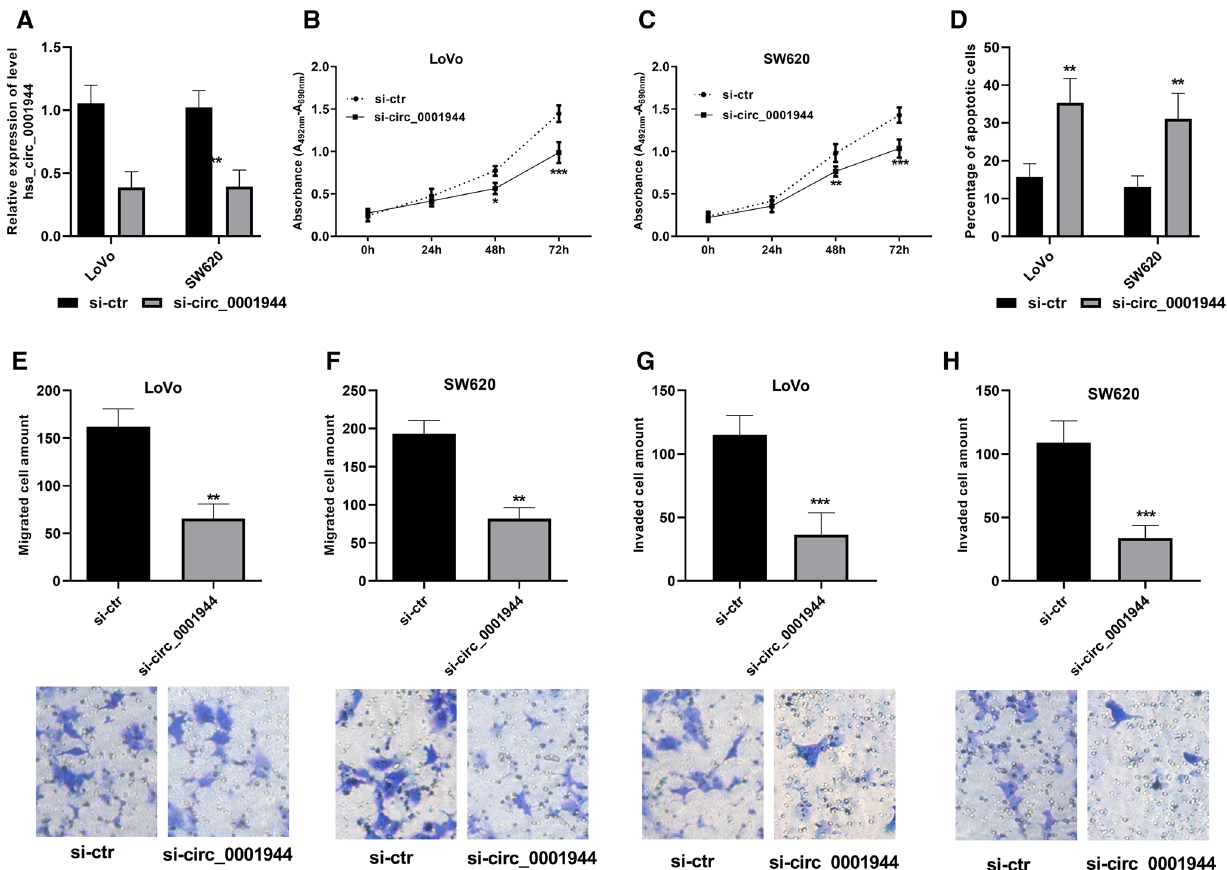
Fig. 2 Inhibition of hsa_circ_0001944 decreased cell proliferation, reduced the migrated and invaded cells, but induced the cell apoptosis. A Verification of the transfection. B , C Cell proliferation was evaluated in LoVo and SW620 cells transfected with hsa_circ_0001944 siRNA (si- circ_0001944), using the negative siRNA as reference. D Quantitative statistical chart of the apoptotic cells. E , F Numbers of migrating cells were determined using Transwell assay. G , H Numbers of invading cells were determined using Matrigel-modified Transwell assay. Student t-test was applied. Error bars are mean ± standard error from three replicate samples. * P < 0.05, ** P < 0.01*** P <